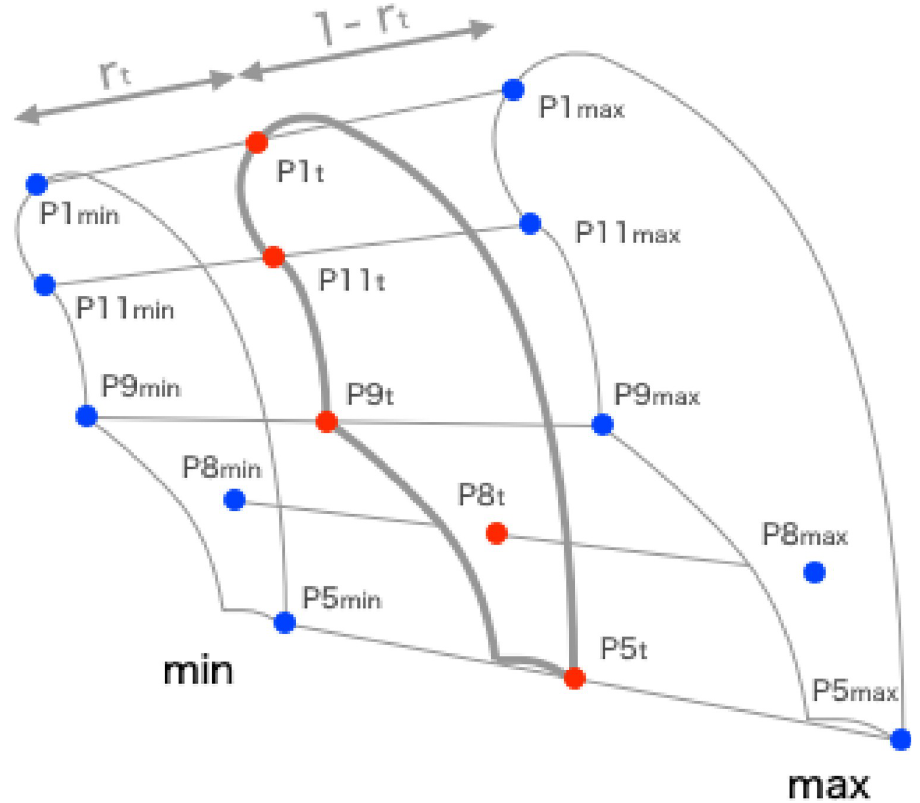
Fig 2. Maximum inspiratory and expiratory images of the lungs.